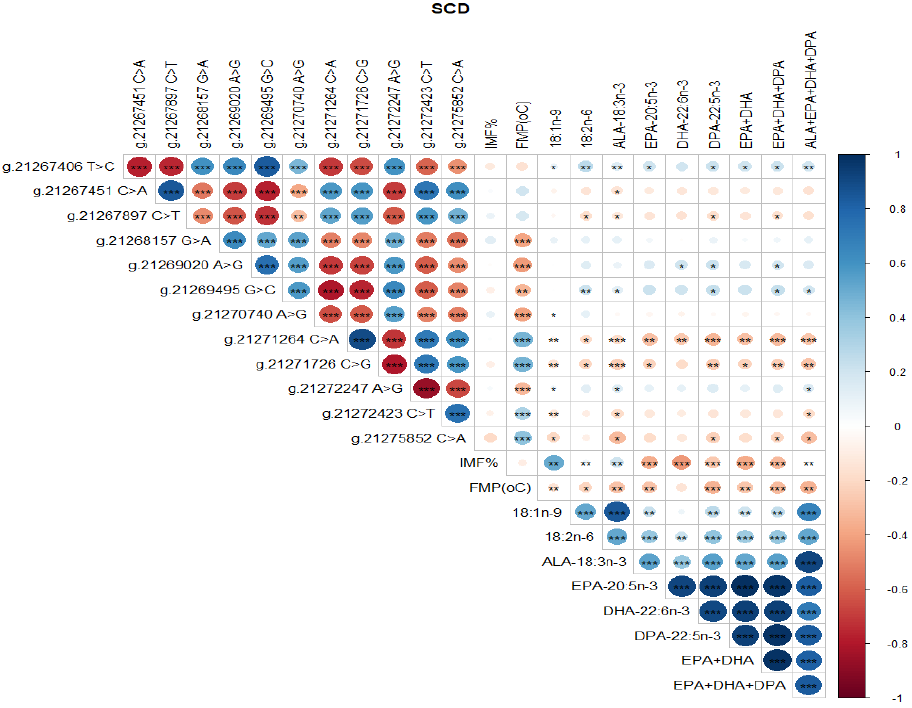
Figure 4. Spearman’s correlations between SCD gene SNP loci, IMF, FMP, and fatty acid profiles of Bowen Genetics Forest Pastoral Angus, Hereford, and Wagyu beef cattle breeds. (* p < 0.05, ** p < 0.01; *** p < 0.001). Dark blue indicates a strong positive relationship, and dark red shows a strong negative relationship.